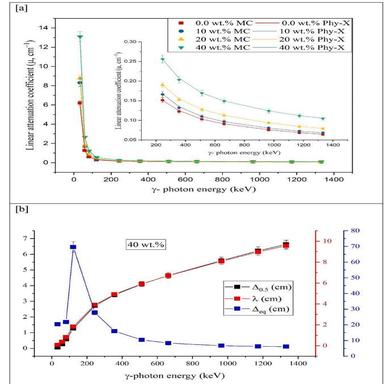
Influence of the applied γ-photon energy on linear attenuation coefficient (μ, cm− 1) and mean free path (λ, cm), half-value thickness (Δ0.5, cm), and the lead equivalent thickness (Δeq, cm) of the fabricated composites.